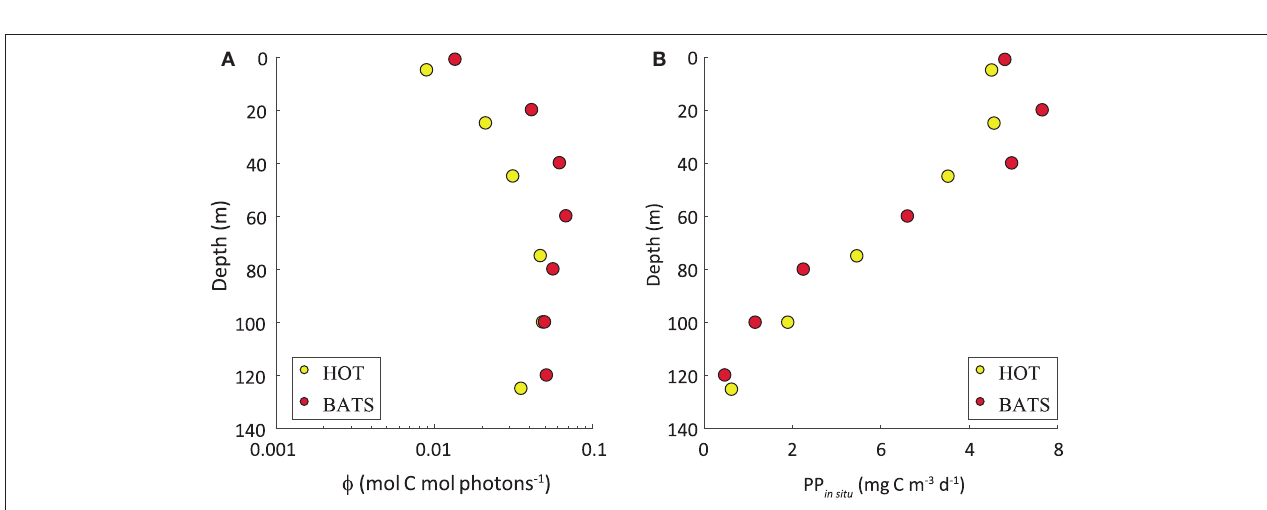
FIGURE 3 | Quantum yield of photosynthesis ( φ , in mol C mol photons − 1 ) estimated from in situ measurements at HOT station, represented in a colorimetric scale (exhibited on the right). The vertical axis shows the depth in meters (from 0 on the top to deeper values on the bottom). The horizontal axis represents time and every point in the graph corresponds to a monthly cruise.